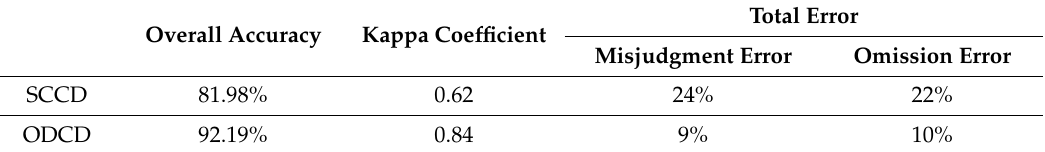
Table 9. Accuracy comparison table between SCCD and